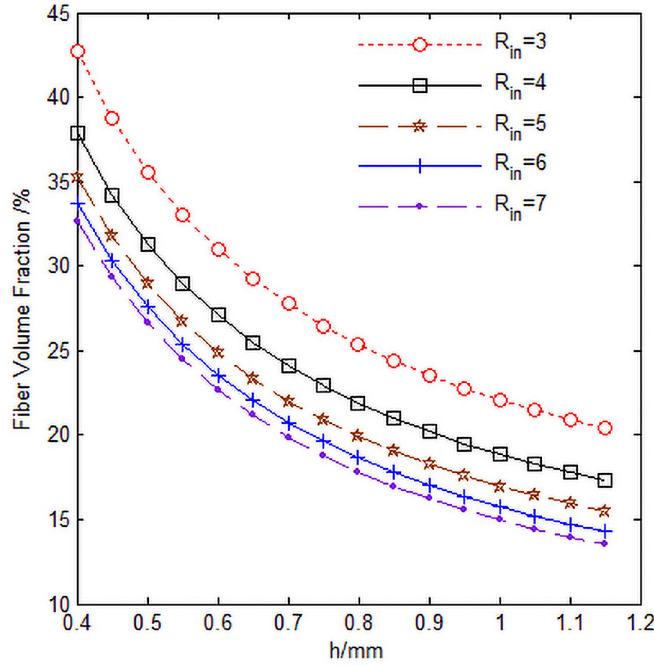
Fig 14. Relationship curve of fiber volume content V f , knuckle length h and cell inner diameter R in .